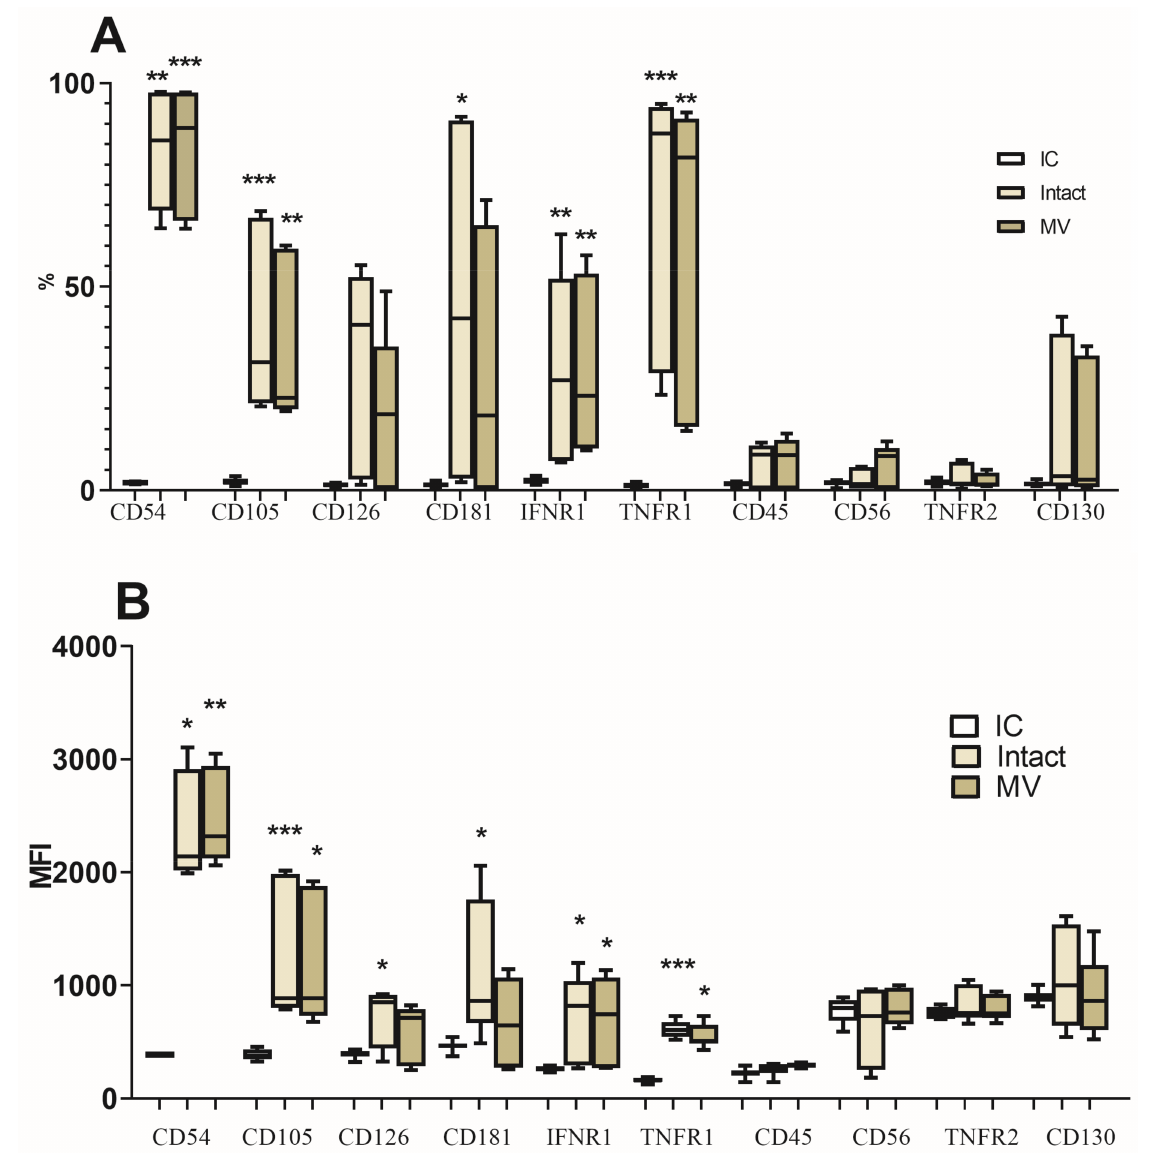
Figure 3. Expression of receptors by JEG-3 cells: ( A ) The relative number of cells expressing receptors (%); ( B ) The mean fluorescence intensity of receptor expression (MFI) (n = 4). Isotype control (IC): JEG- 3 cells treated with isotype antibodies. Intact cells (Intact): JEG-3 cells incubated in medium without MVs added. MV: cells of JEG-3 line incubated in the presence of MVs of NK-92 cells. Significant difference from JEG-3 cells treated with isotype antibodies: * p < 0.05, ** p < 0.01, *** p <